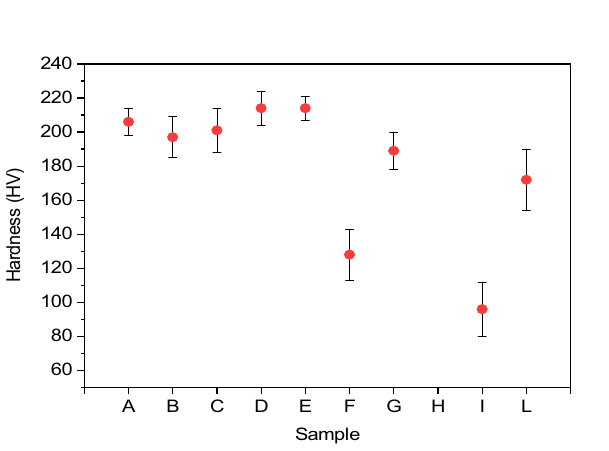
Figure 2. Average potential versus pulse time (t on ), estimated for each t c /t a ratio (t c /t a = 3; 7; 20) at different cathode pulse times.